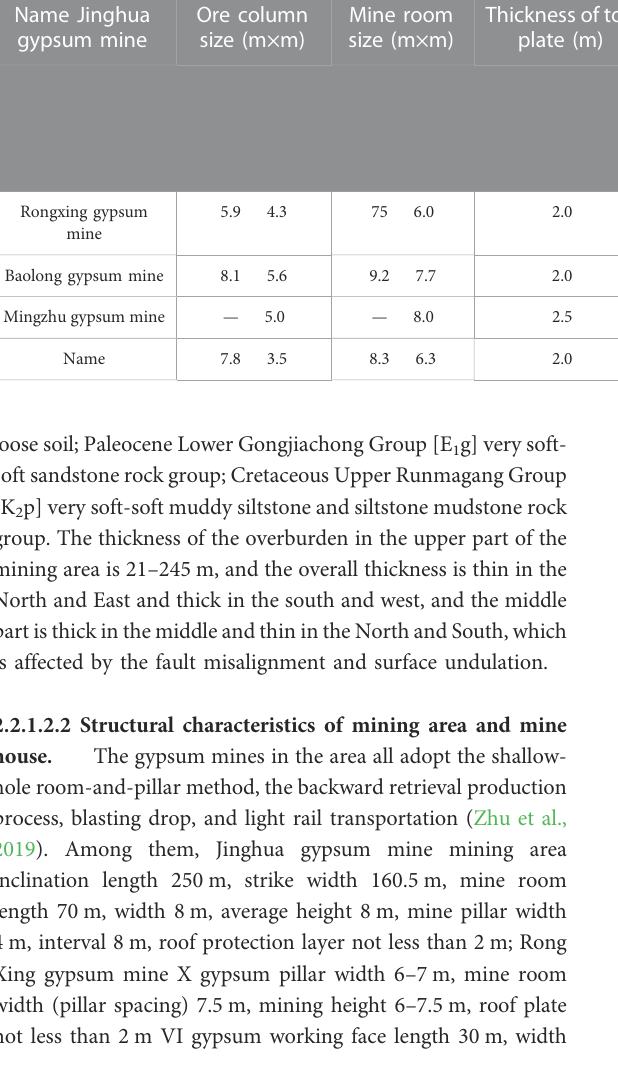
TABLE 3 Gypsum mine goaf structure survey form. Name Jinghua gypsum